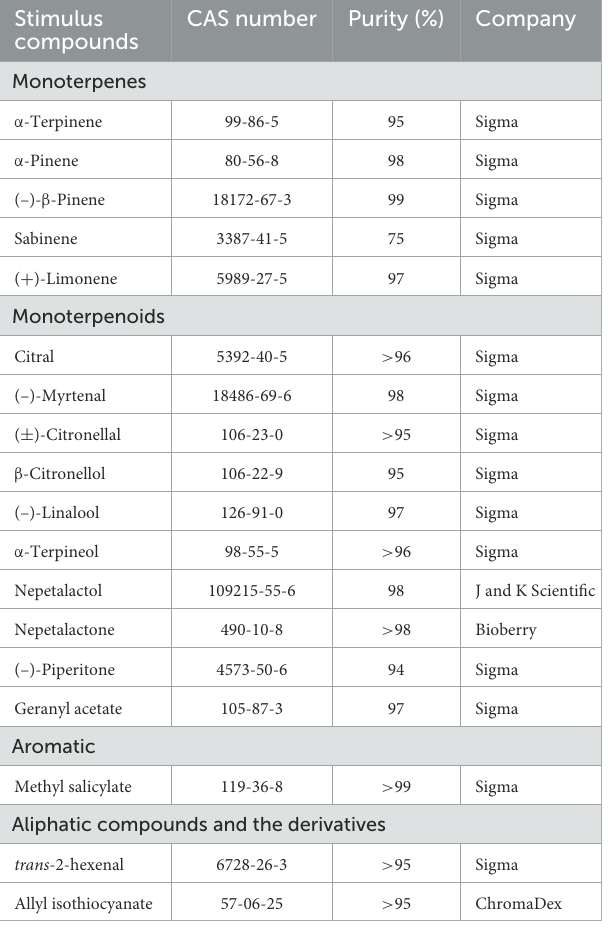
TABLE 1 Chemicals used for single sensillum